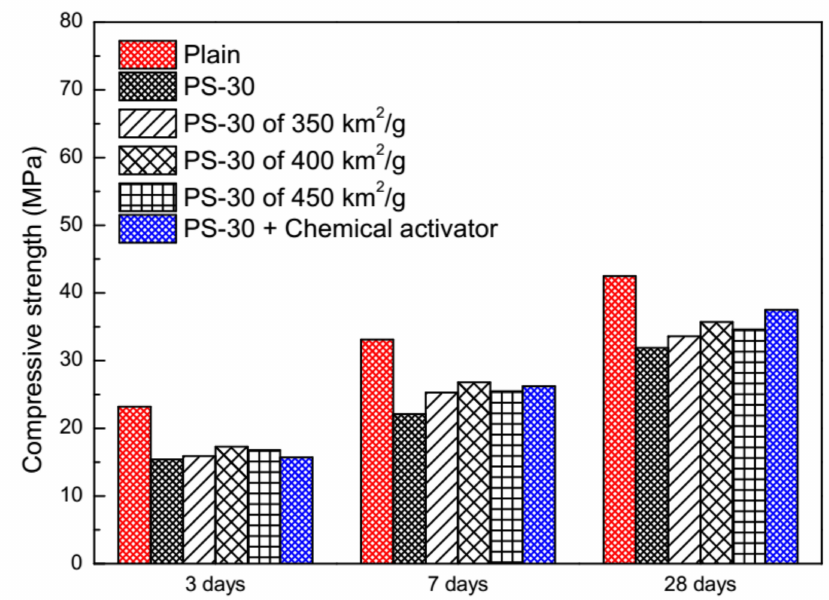
Figure 7. Compressive strength of cement mortars with 30% by mass of phosphorus slag under the physical activation and the chemical